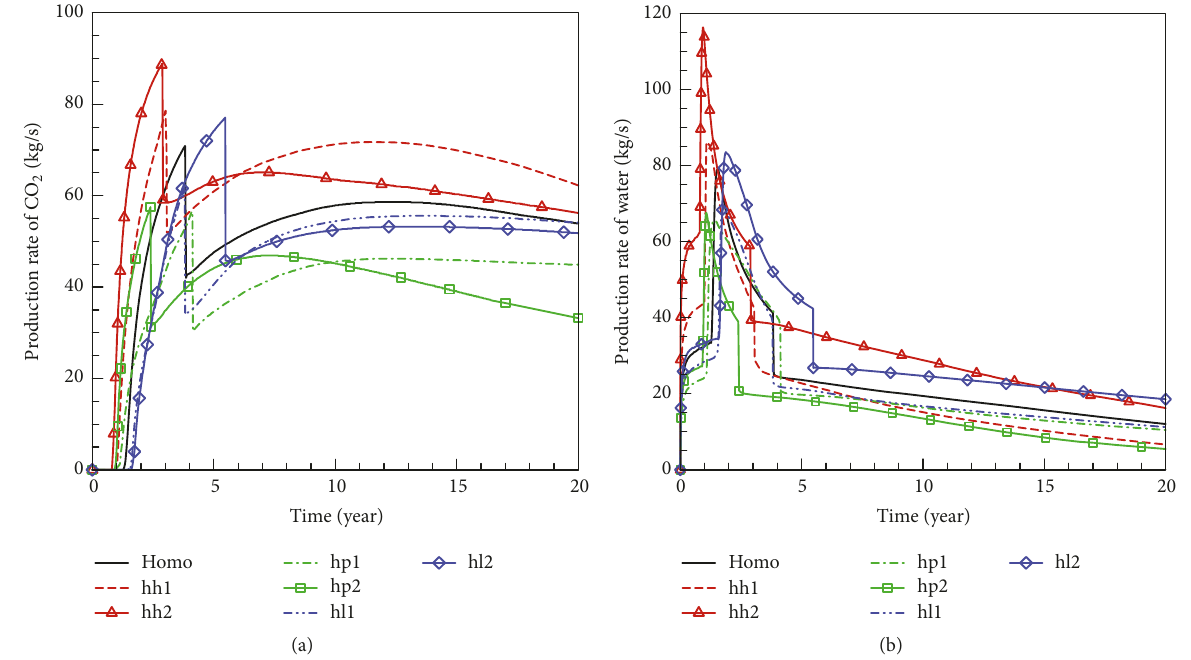
Figure 6: Variation of production rate of CO 2 (a) and water (b) versus time for different cases.